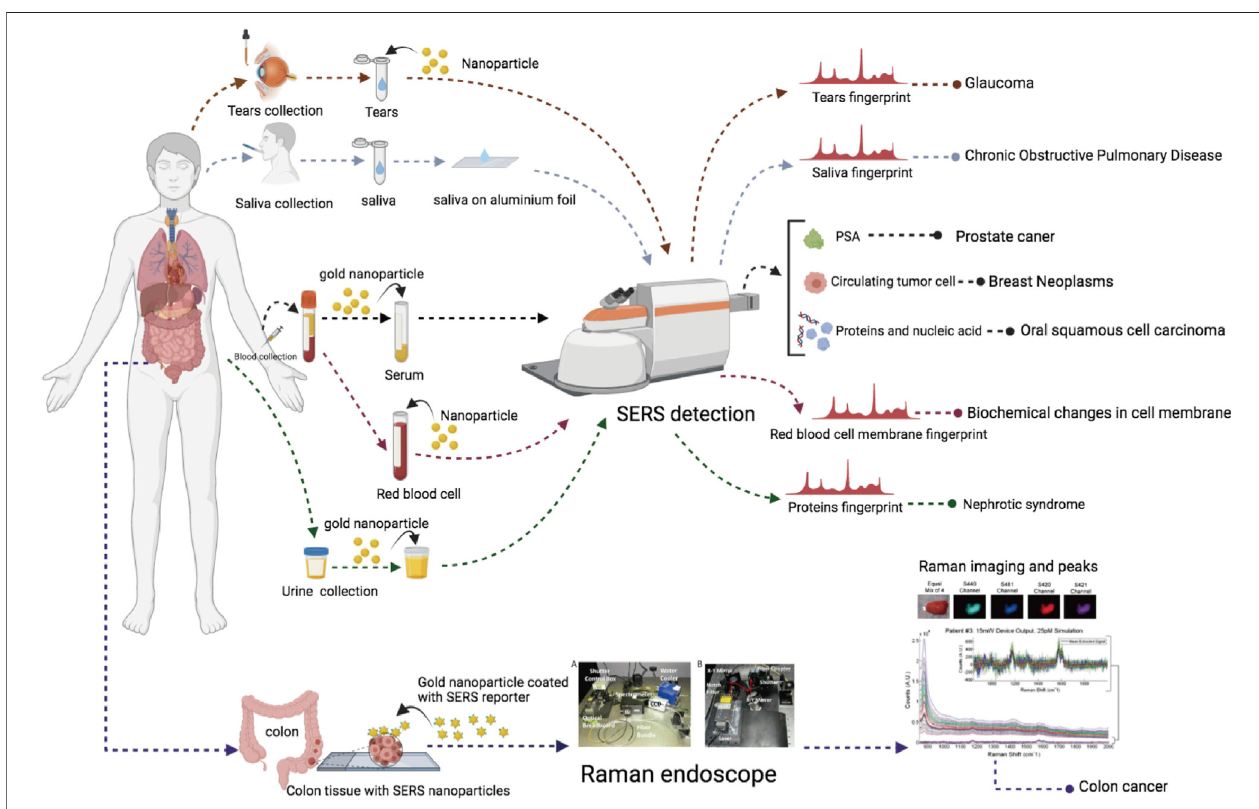
FIGURE 3 | Illustration of SERS registered and published clinical